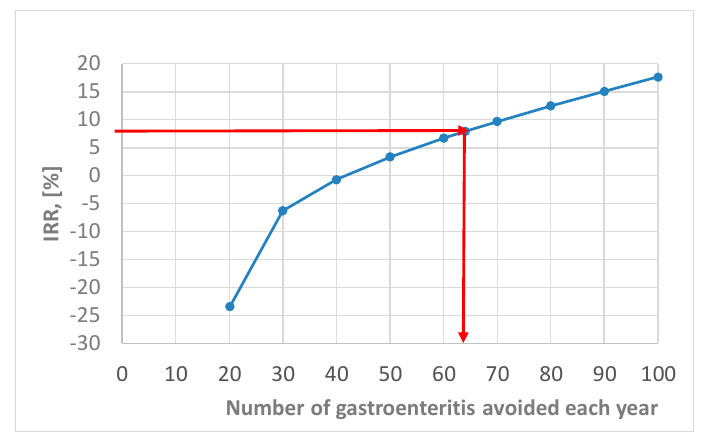
ffi cacy of the